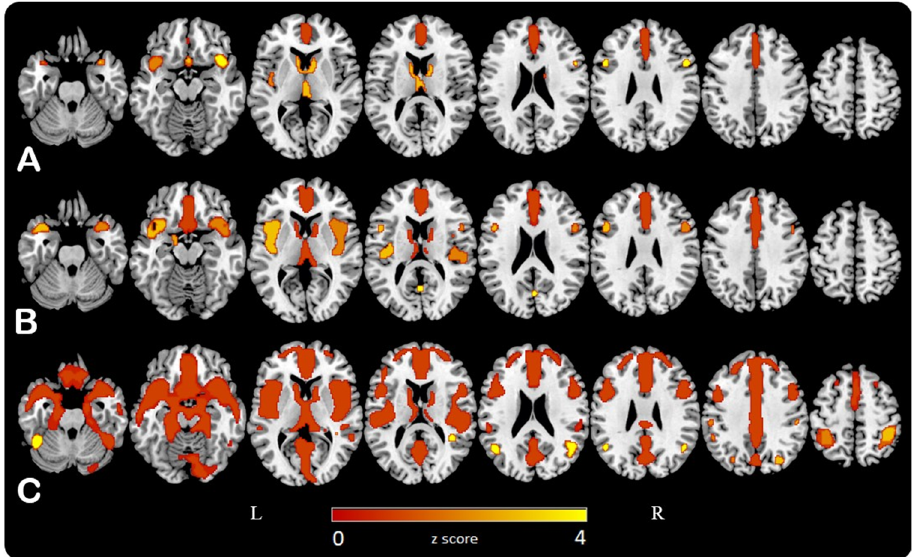
Figure 1. Statistical parametric maps (SPMs) are represented on a color-coded scale (0 < z < 4) and displayed on a standardized brain magnetic resonance imaging. SPMs showed a negative correlation between age and FDG uptake values when cerebral global mean ( A ), white matter ( B ) and pons ( C ) 18F-FDG activity were considered as normalising reference, respectively.